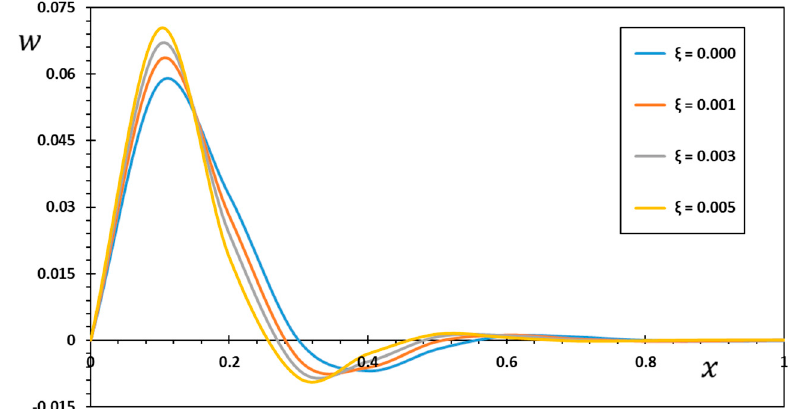
Figure 6. The thermal deflection, w , under various nonlocal parameter ξ values.